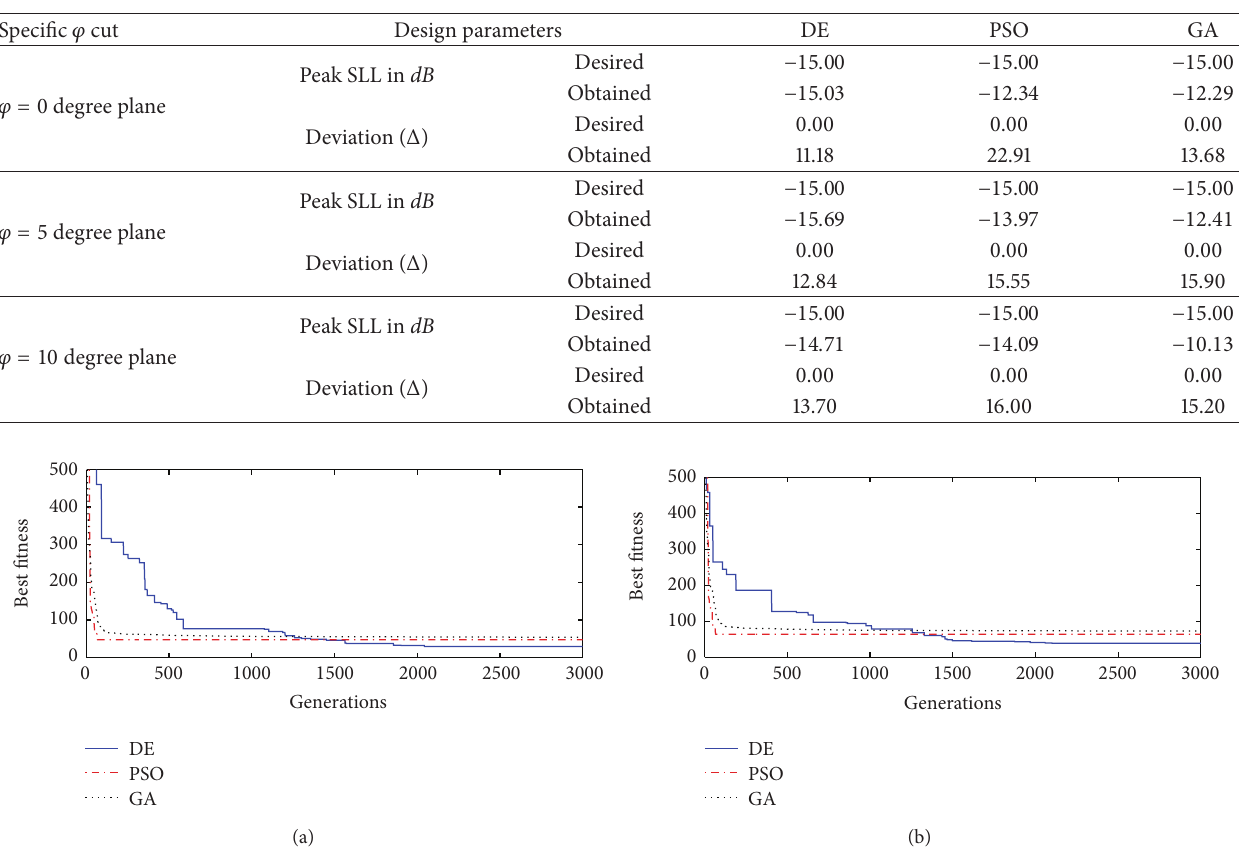
Table 3: Desired and obtained results for Case II of the design problem.